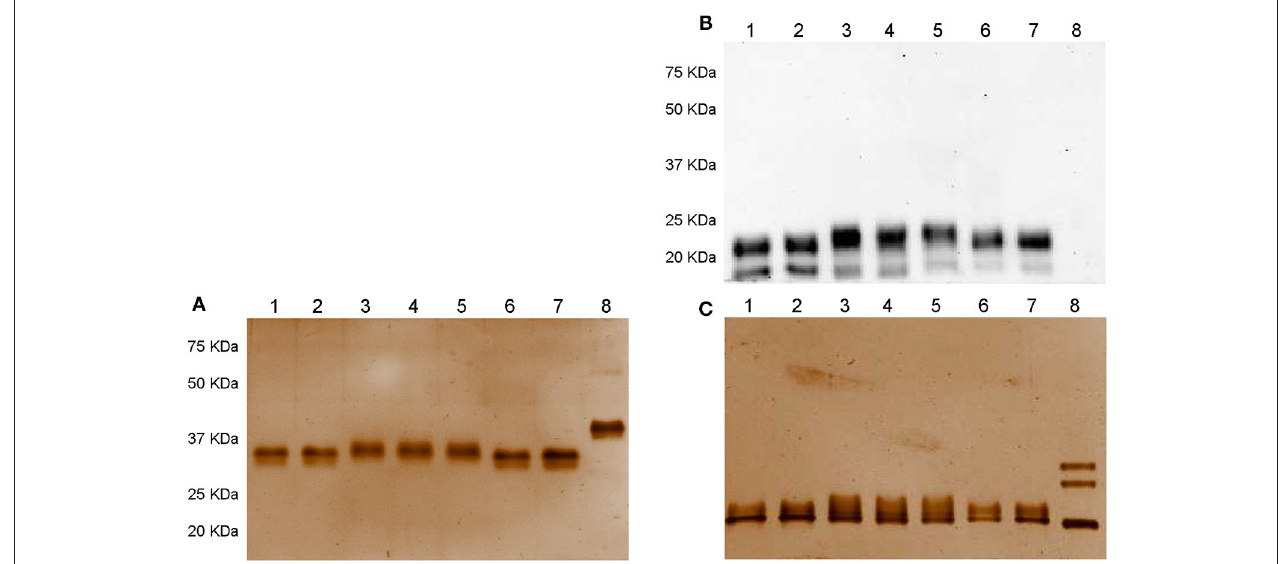
FIGURE 1 | Western blotting (A) and silver staining analysis (B,C) of Gonal-f ® and biosimilars under non- denaturing -non reducing and denaturing-reducing conditions. Samples comprising 300 ng of each preparation, according to the quantification provided by the manufacturer, were loaded. FSH presence was detected by rabbit anti-human polyclonal primary antibody against FSH β /FSH. Recombinant hCG was used as negative control. Samples were loaded as follows: (1) Ovaleap ® batch R38915, (2) Ovaleap ® batch S27266, (3) Bemfola ® batch PPS30400, (4) Bemfola ® batch PNS30388, (5) Bemfola ® batch PNS30230, (6) Gonal-f ® batch AU016646, (7) Gonal-f ® batch BA045956, (8) recombinant hCG. (A) Evaluation of FSH preparations under denaturing-reducing conditions, by Western blotting, using anti-FSH β antibody. (B) Silver staining analysis of FSH preparations under non-denaturing-non reducing conditions. (C) Analysis of FSH preparations under denaturing-reducing conditions, by silver